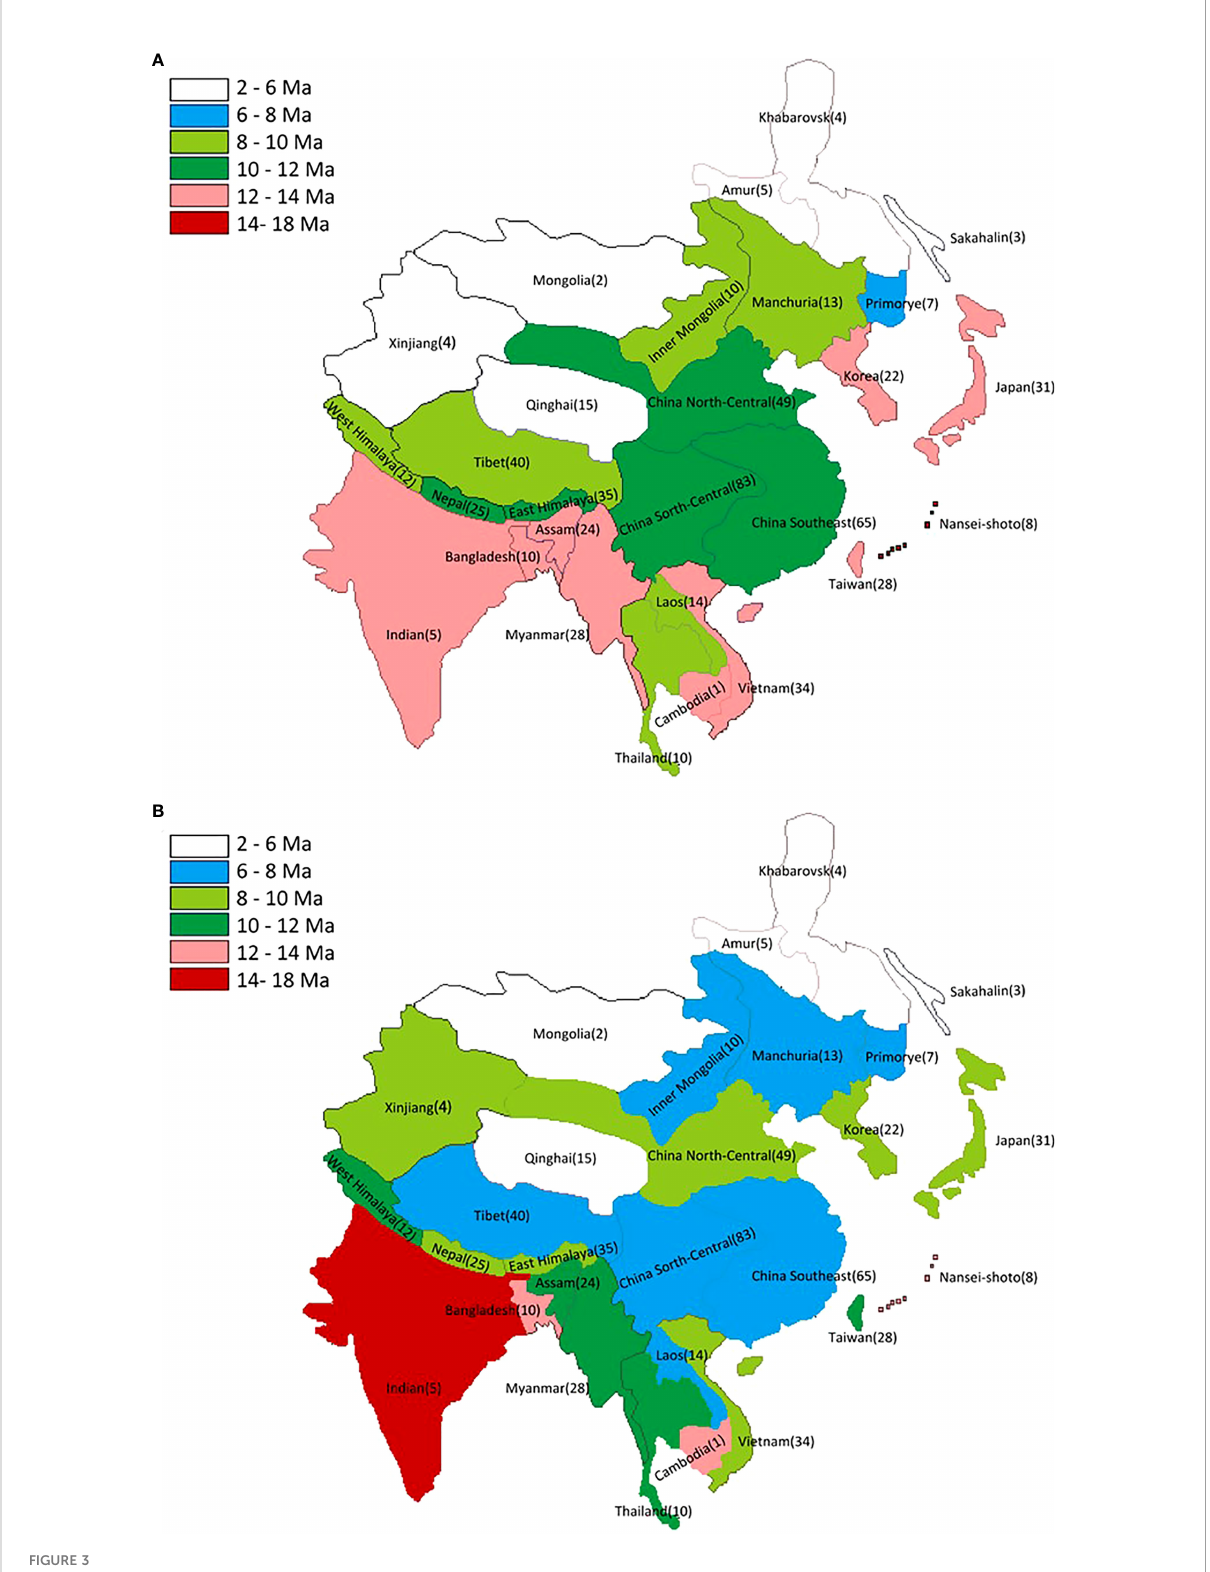
FIGURE 3 Pattern of the mean diversi fi cation times (MDTs) (A) and the average diversi fi cation times (ADTs) (B) for the East Asian endemic plant taxa. The numbers of taxa distributed in each region are